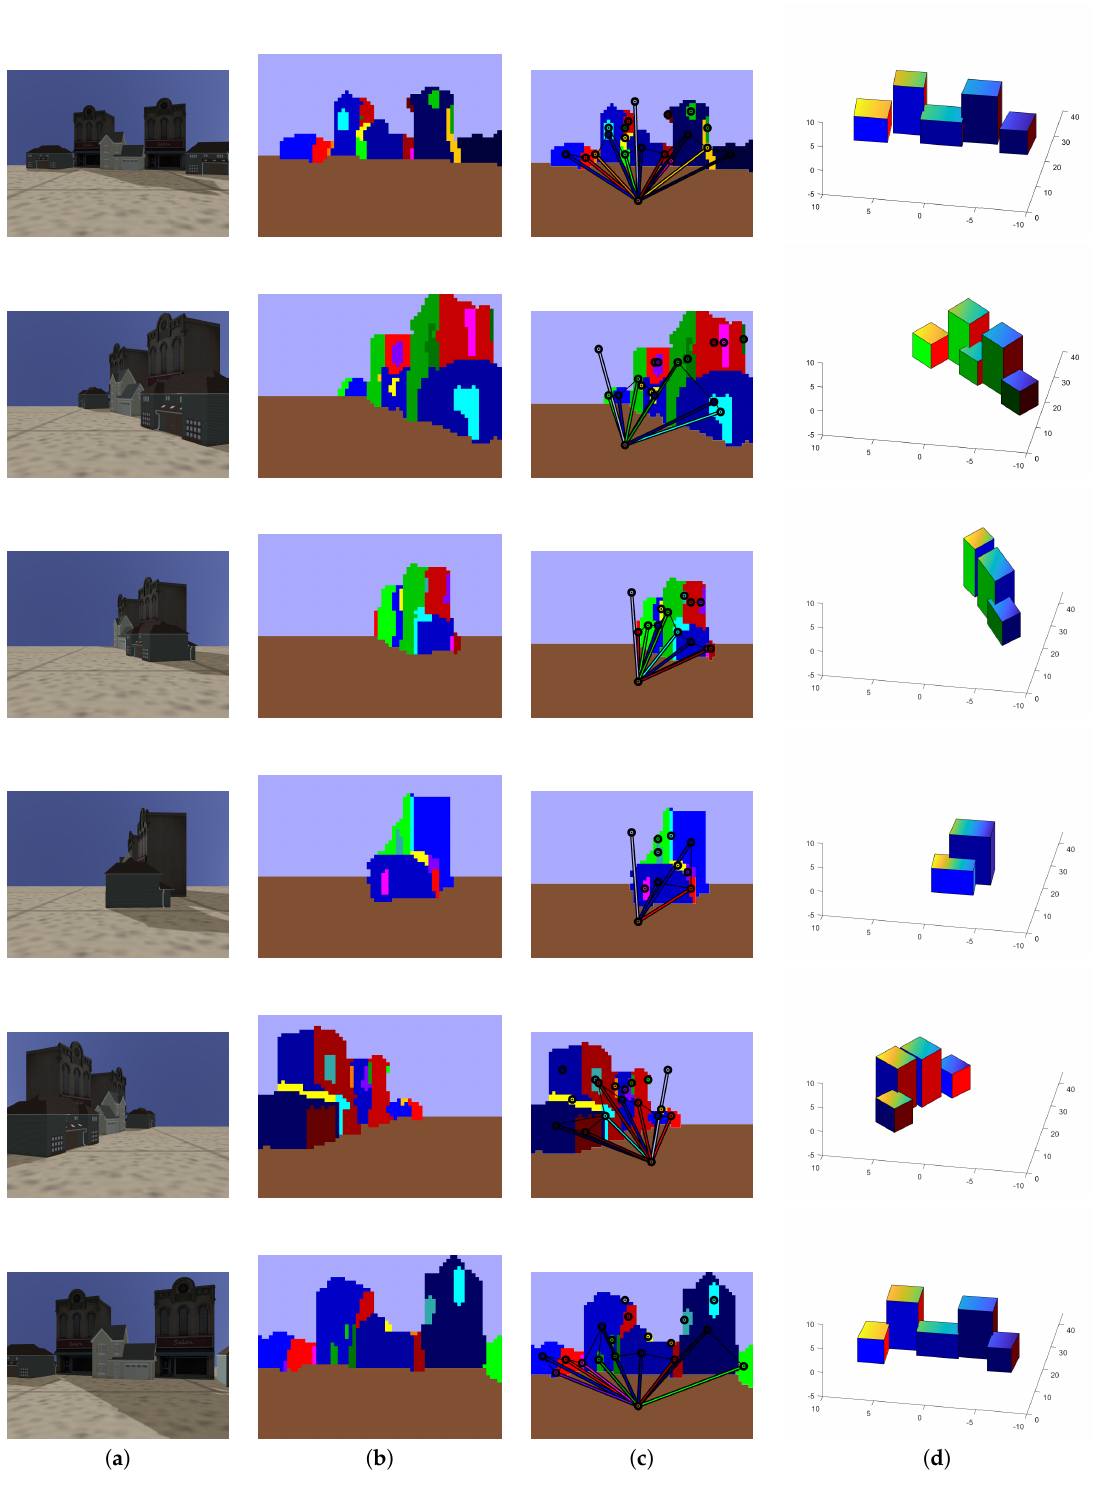
Figure 8. Our HLS extraction method on our simulated images. ( a ) Input image; ( b ) Orientation segmentation; ( c ) Graph analysis; ( d ) HLS